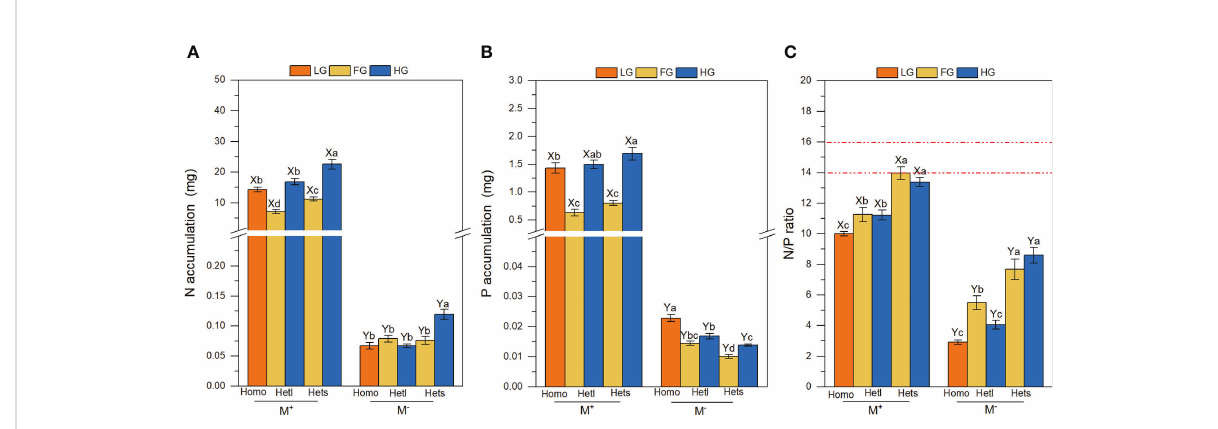
FIGURE 3 The N accumulation, P accumulation and N/P ratio of B pilosa . For the N accumulation (A) , P accumulation (B) , and N/P ratio (C) of B. pilosa, M + and M – ; Homo, Hetl and Hets; LG, FG and HG substrates, implications are the same as in Figure 2. The implications of the X and Y, the (a – d) above the bars are the same as in Figure 2.